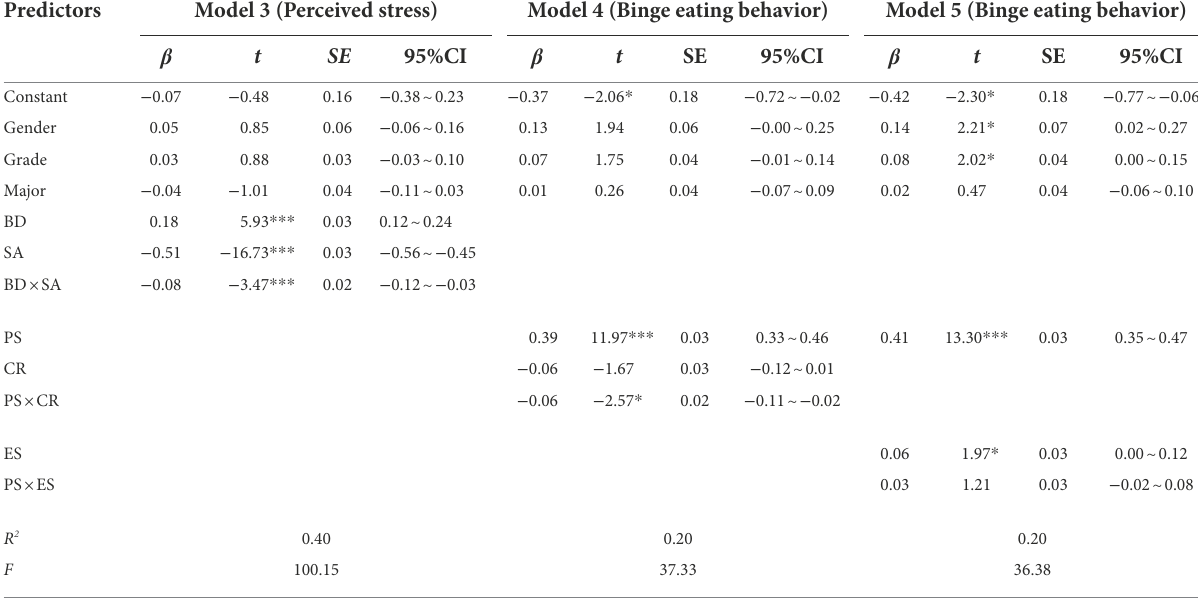
TABLE 3 Testing the moderation effect of self-acceptance, cognitive reappraisal and expressive suppression.